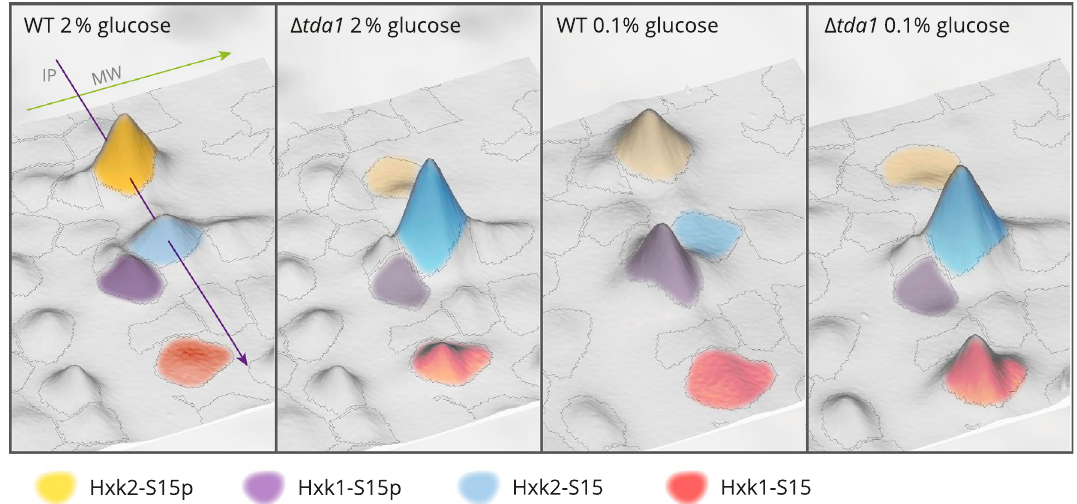
Figure 3. Spots representing Hxk1 and Hxk2 in their phosphorylated and unphosphorylated forms. A proteomic comparison of BY4742 wild type and Δ tda1 deletion mutant cells grown with different initial glucose concentrations (0.1% or 2% (w/v)) was conducted employing 2D-DIGE. The four main spots containing hexokinases are shown for every combination of conditions. The fluorescence intensities measured by fluorescence scans of the 2D-DIGE gels are presented as elevations from the IP-MW plane. The volume of a spot serves as a measure for quantification of the proteins identified in the spot. Representative images were chosen to provide an intuitive understanding of the spot landscapes, which were also analyzed quantitatively (Fig. 4 and supplementary Fig. S4). The spot borders shown are the ones automatically defined by the Melanie 2D-DIGE analysis software.